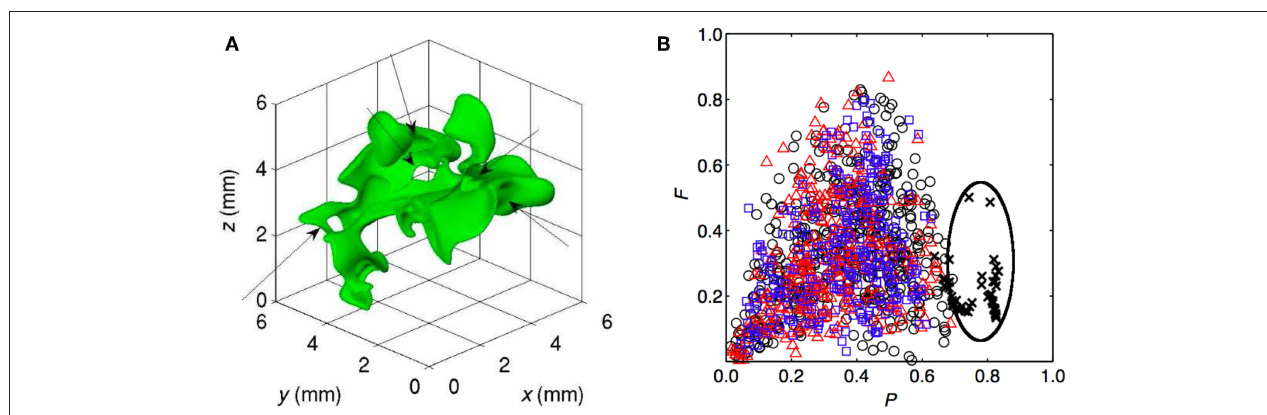
Frontiers in Mechanical Engineering |